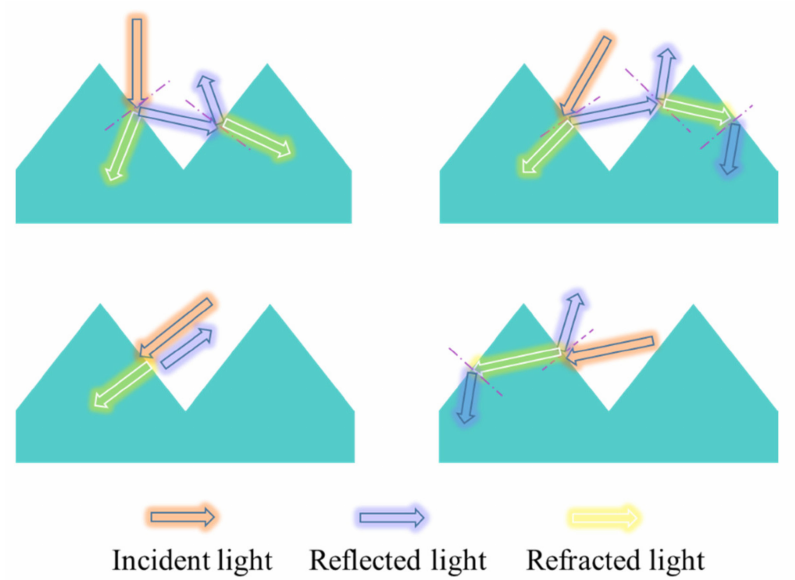
Figure 5. Schematic diagram of light trapping effect of inverted pyramid microstructure.